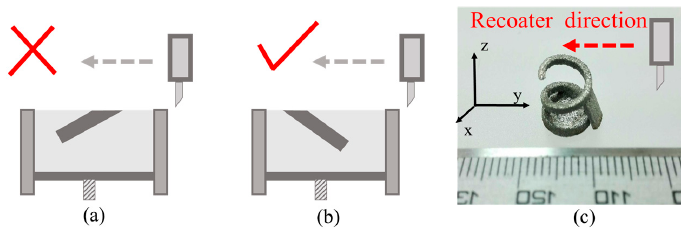
Figure 6. The fiercest ( a ) and weakest ( b ) collision during structure building with a rising angle of 30° and ( c ) manufacturing by SLM after generating support.